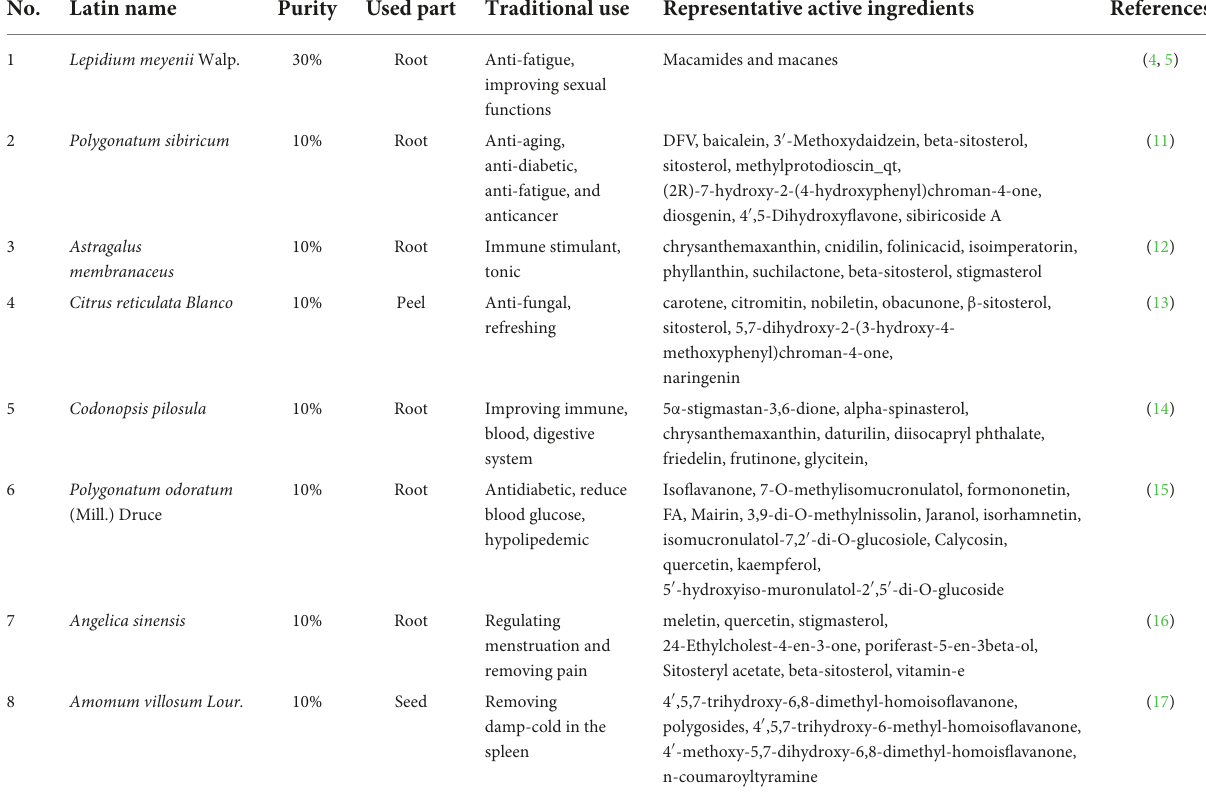
TABLE 1 The list of the edible or medicinal plants in Maca compound preparation